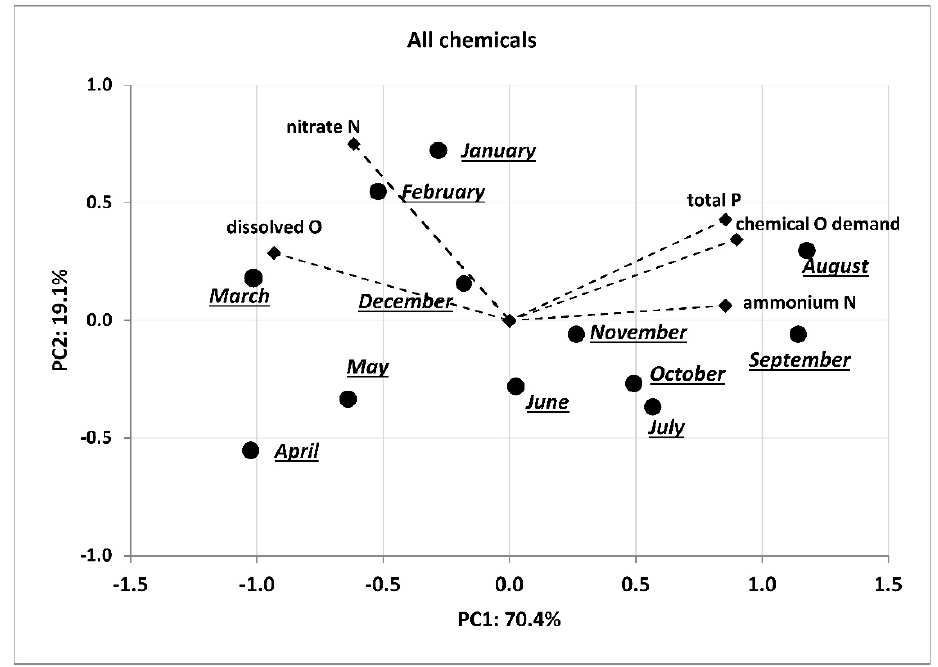
Figure 13. PCA analysis for the relationships between: concentration of total phosphorus, nitrate nitrogen, ammonium nitrogen, dissolved oxygen and chemical oxygen demand during the months of April 2019–March 2020.